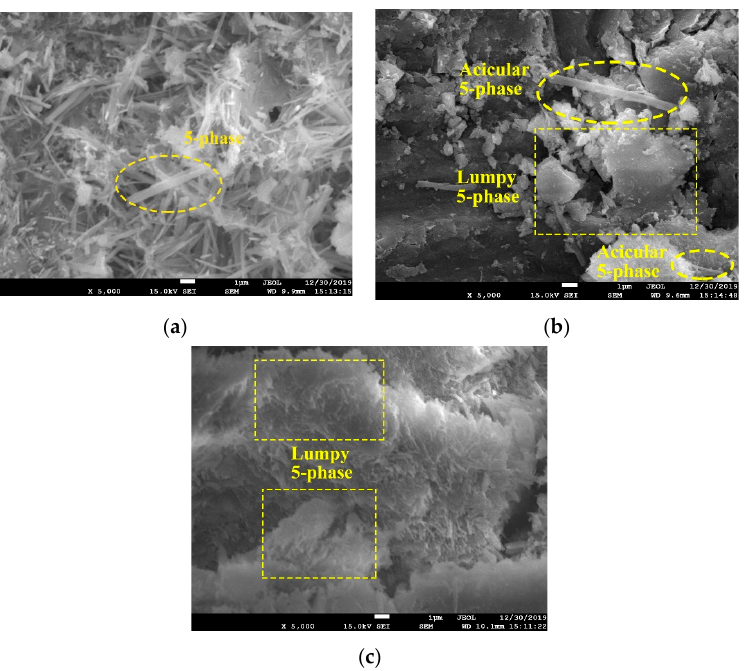
Figure 7. SEM observation of MOC sample ( a ) Group O; ( b ) Group A1; ( c ) Group A4.